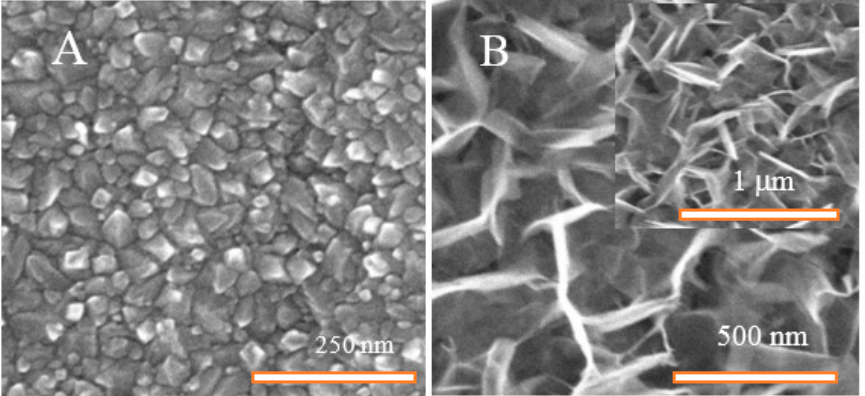
Figure 1. Top-side SEM images of the Ti surface after hydrothermal treatment in the solution of NaOH (pH = 11.0) at 150 ° C for 15 h ( A ) and 0.3 mol L -1 H 2 SeO 3 + NaOH solution (pH = 10.0) at 150 ° C ( B ).